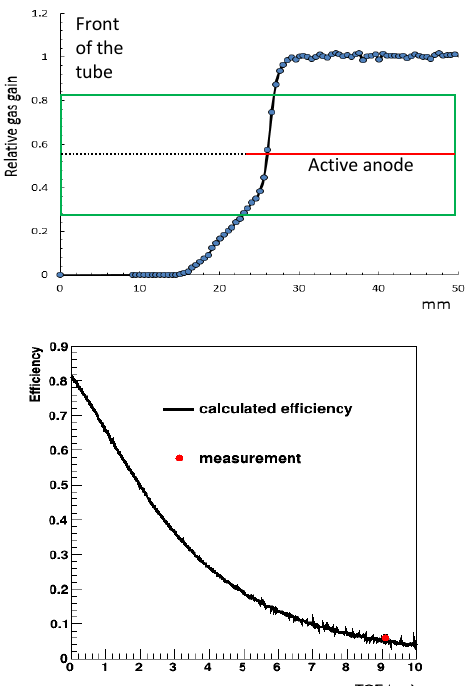
Fig. 4. (a) Detection efficiency along the length of the 3 He tube. The dead zone is approximately 26mm long; (b) Calculated detector efficiency with GEANT4 together with a superimposed experimental calibration point (red) measured on Orphée. The average detection efficiency of the detector was